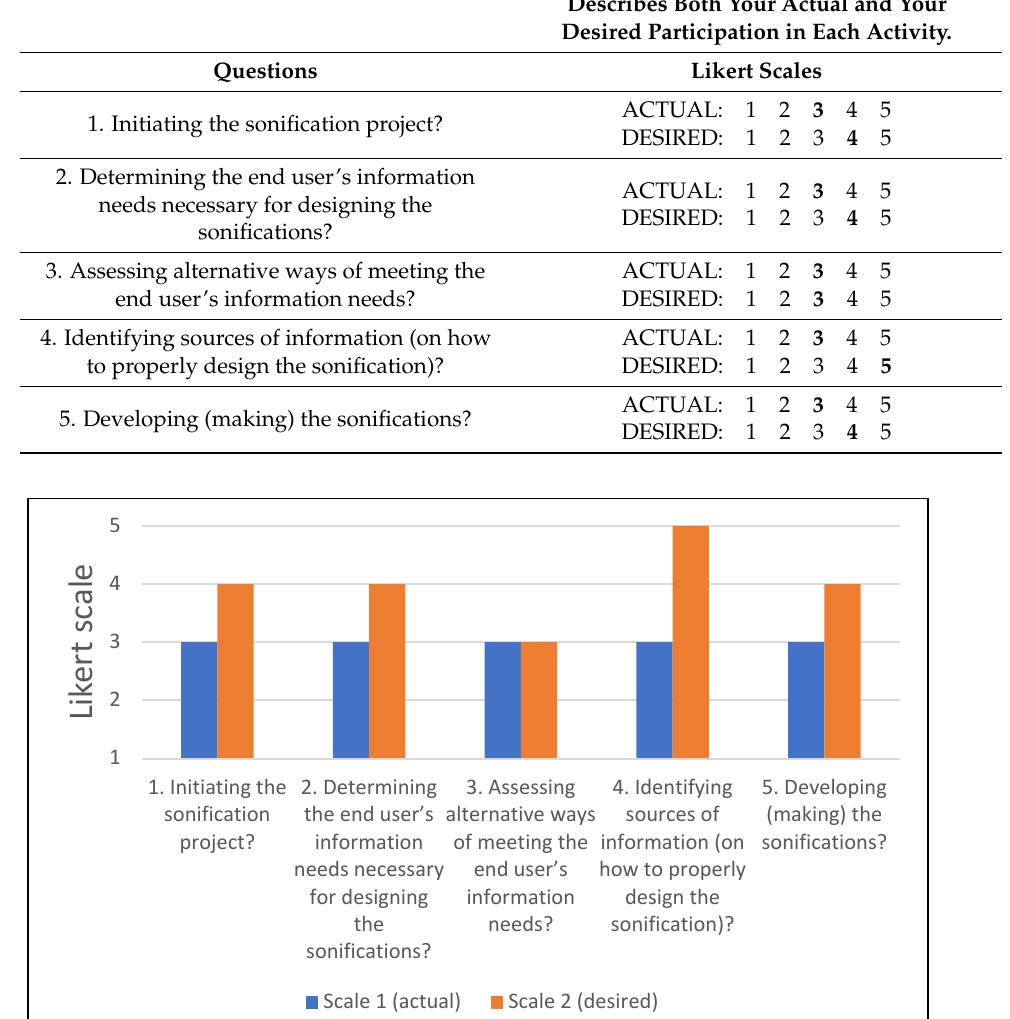
Figure 6. Graph showing the Likert-scale results from Table 2.